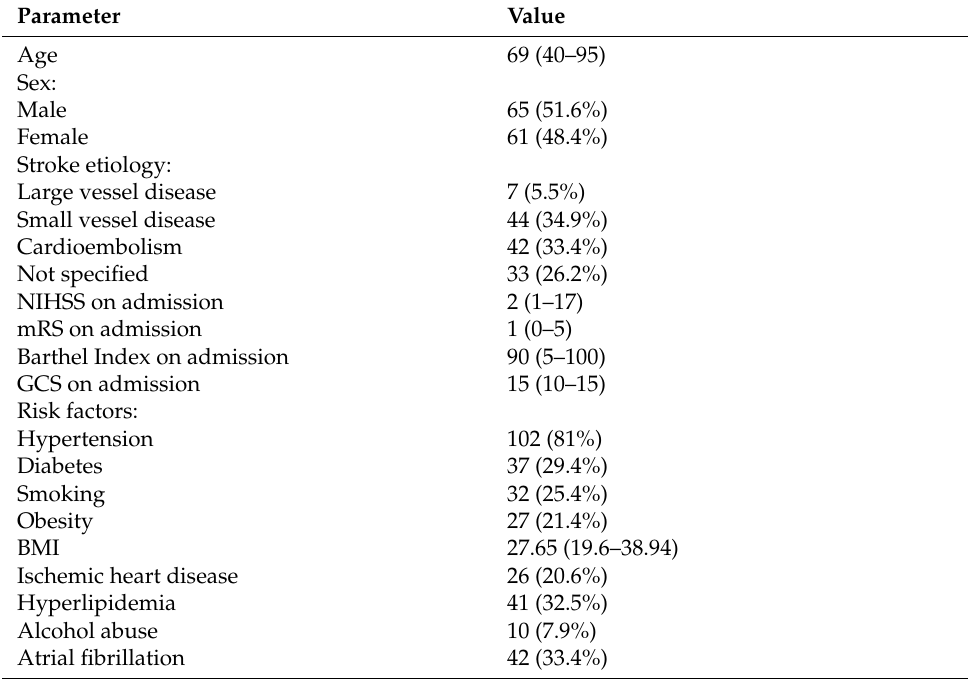
Table 2. Baseline characteristics of the participants ( n = 126).